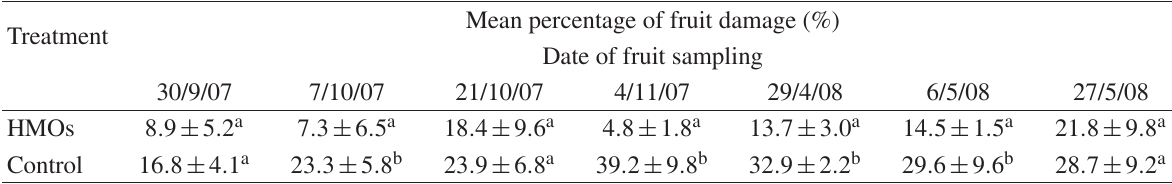
TABLE 1: Influence of n C24 horticultural mineral oils (HMOs) deposits on damage by Eudocima fullonia on Honey Mandarin during September – November 2007 and April-May 2008.